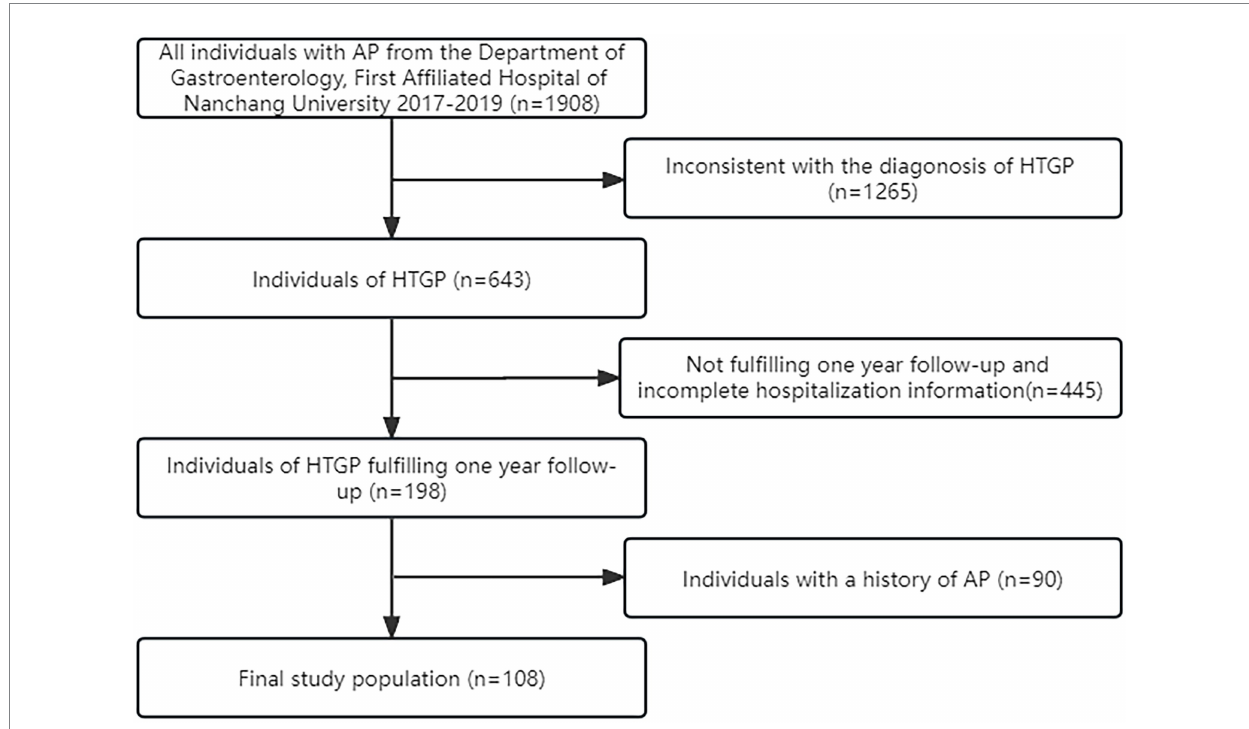
FIGURE 1 Flow-diagram for selection process of the study group of hypertriglyceridemic pancreatitis